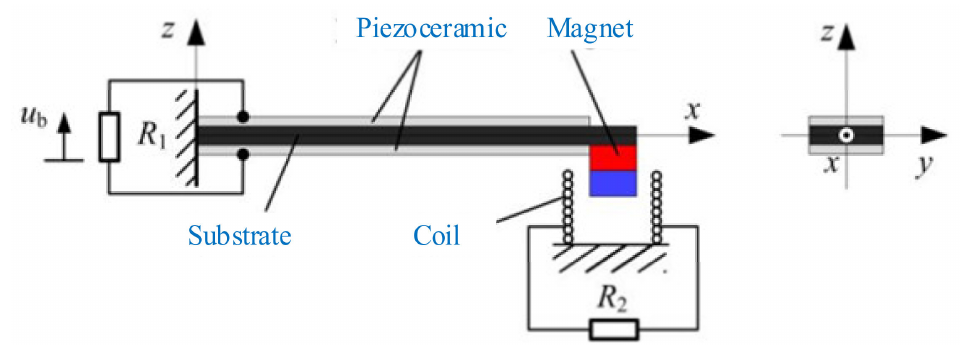
Figure 16. A typical hybrid energy harvester (reproduced with permission from [205]; published by MDPI, 2017).